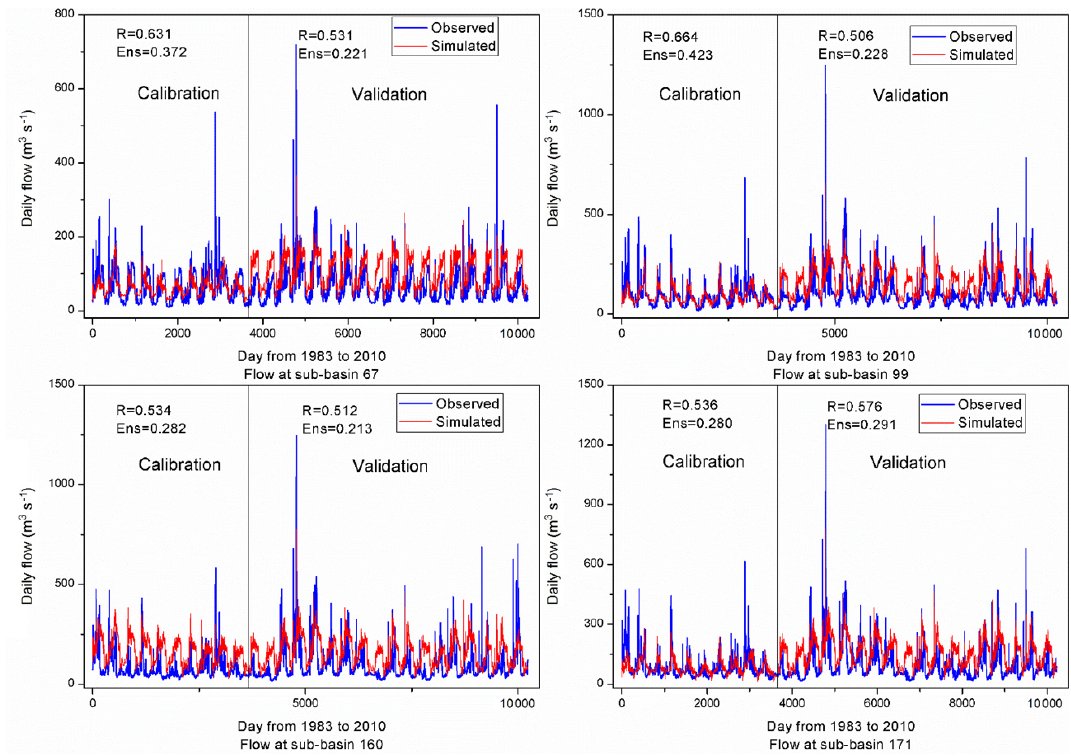
Figure 6. Calibration and validation results under the R2S1 scenario (RiverWare for reservoir operation and surface water as the water source for